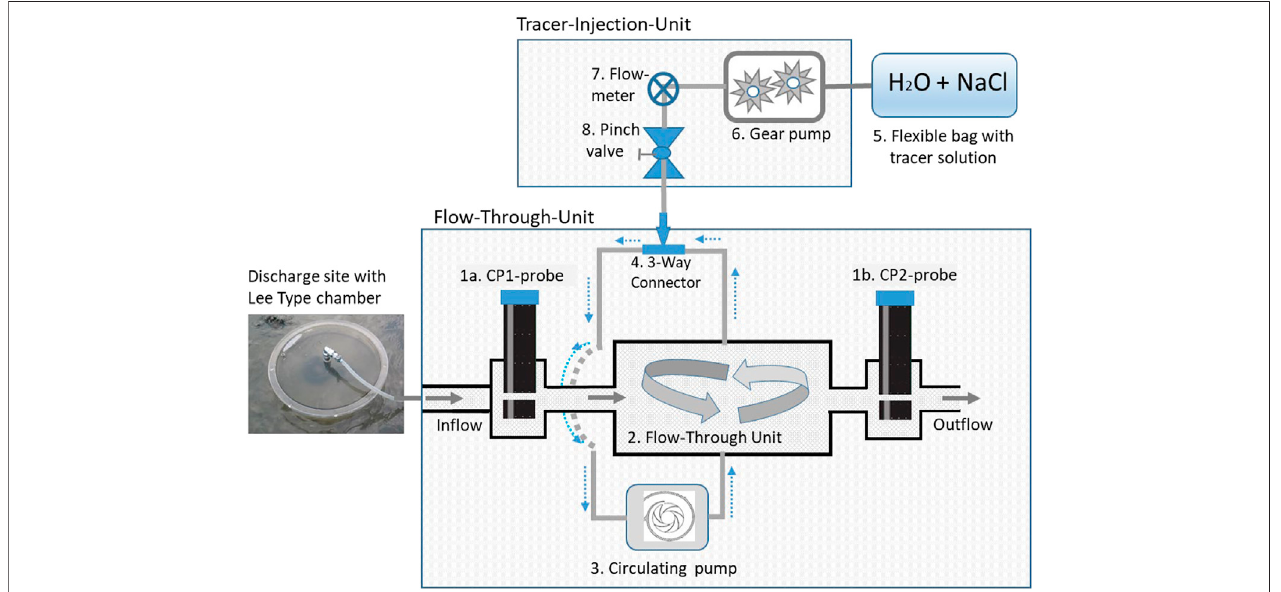
FIGURE 6 | Schematic diagram of the process fl ow: 1a, b. Conductivity probe at in fl ow (CP1) and out fl ow (CP2) of the FTU, 2. Flow-through unit (FTU), 3. Circulating pump, 4. Three-way tube connector for tracer injection by the TIU, 5. Flexible bag holding the tracer solution, 6. Gear pump, 7. Impeller fl owmeter, and 8. Pinch valve.